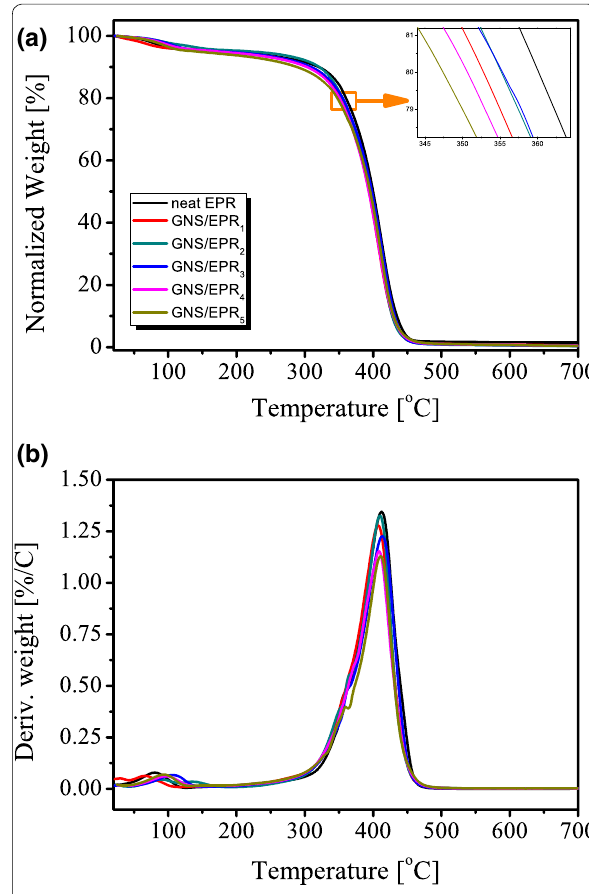
Fig. 4 TGA ( a ) and DTG ( b ) thermoanalytical curves of neat EPR and its GNS/EPR 1–5 graphene‑containing